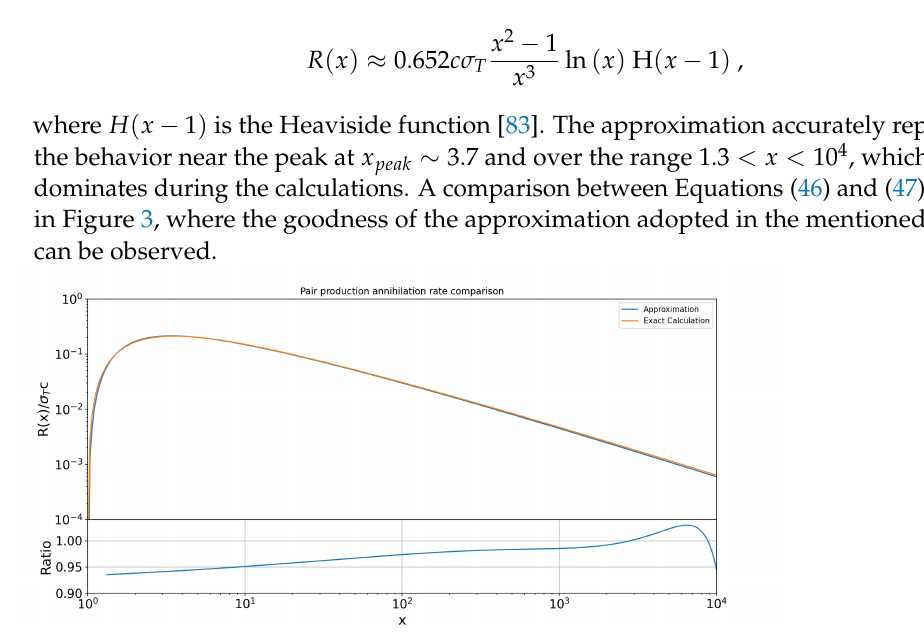
Figure 3. Comparison between the exact annihilation rate (Equation (46)) and the approximated formula (Equation (47)). The ratio between the two curves in the range (1.3 < x < 10 4 ) is shown in the bottom panel. In this range, the ratio is always (cid:46)